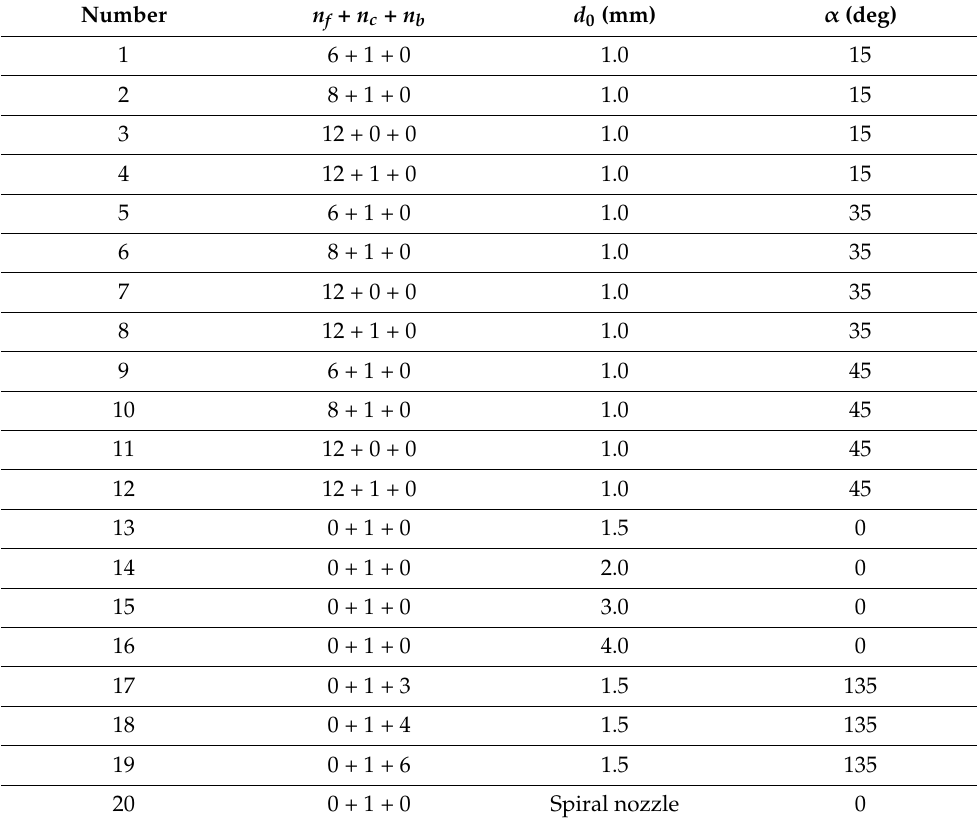
Table 2. Structural parameters of the nozzles used in the experiments.